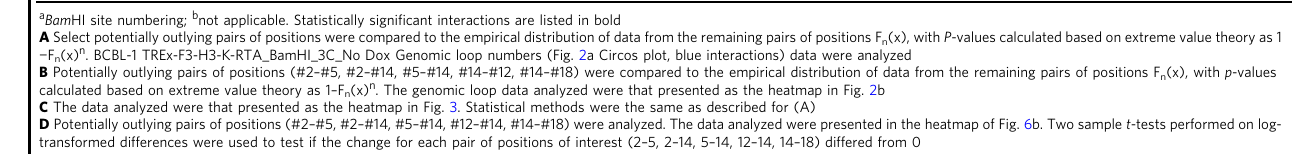
with bright red arrow) were detected in the presence of K-Rta (Fig. 6c red arrows). Bam HI fragments that do not contain a K- Rta binding site were also included as a comparison (Fig. 6c blue arrows). KSHV episome copy numbers in the i SLK cells were also measured by qPCR and found that PAN Mu contained 50% more KSHV episomes relative to WT in the i SLK cells (Fig. 6d). Effects of K-Rta binding at the PAN promoter on genomic loop for-